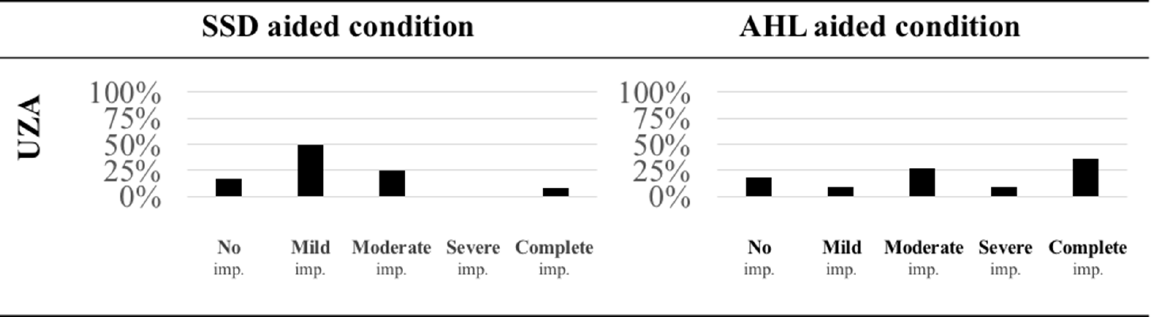
Figure 5. Application of the HEARRING_LOC_ICF scale on data from the Antwerp University Hos-